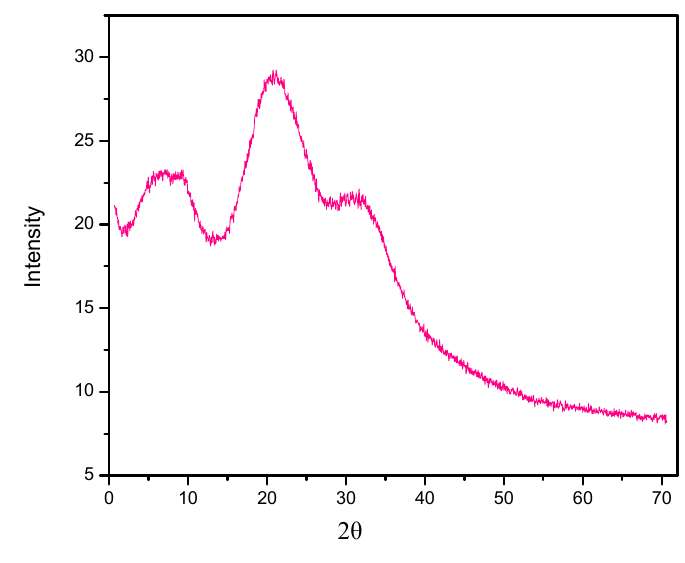
Figure 8. X-ray diffractogram of CS/TPP.